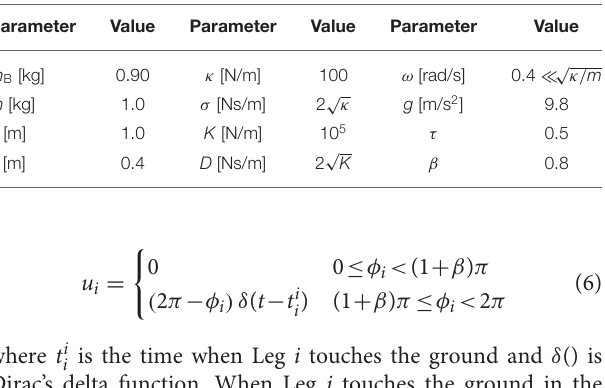
TABLE 1 | Parameters for simulation.